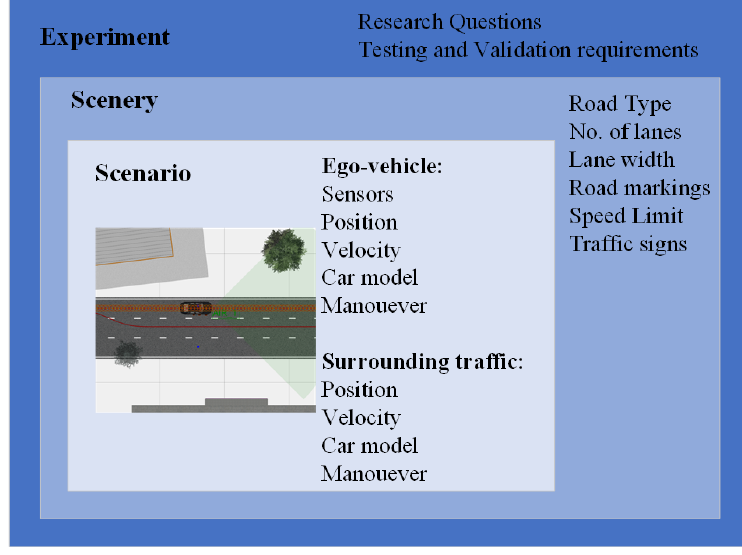
Figure 3 . Ontology and hierarchy for simulation experiments adapted from [30]. Figure 3. Ontology and hierarchy for simulation experiments adapted from